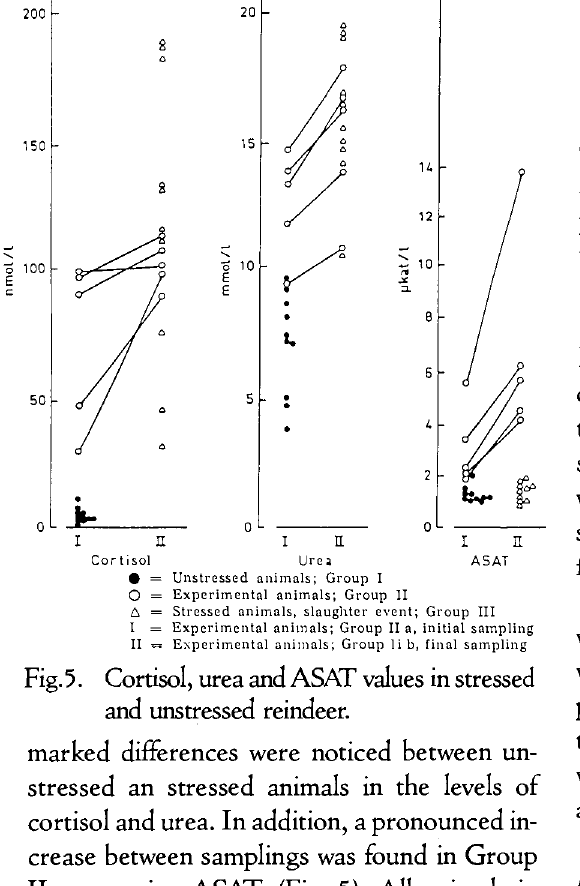
Fig. 5. Cortisol, urea and ASAT values in stressed and unstressed